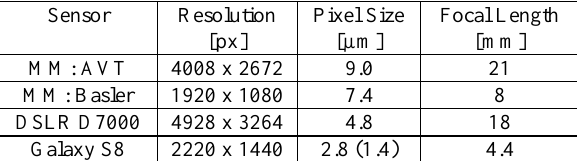
Table 1. Overview of the sensors used in our evaluation